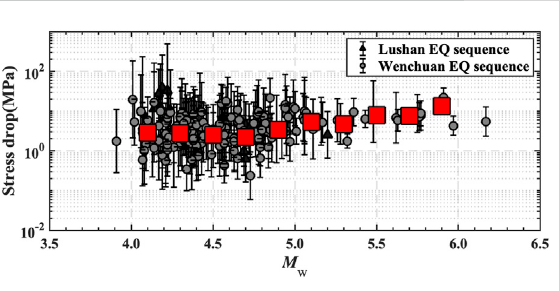
FIGURE 5 Stress drop estimates versus moment magnitude and ± 1 standard deviation for the estimated parameters (vertical black lines) for the Lushan and Wenchuan earthquake sequences. Red squares plot the median stress drop in 0.2 moment magnitude bins.